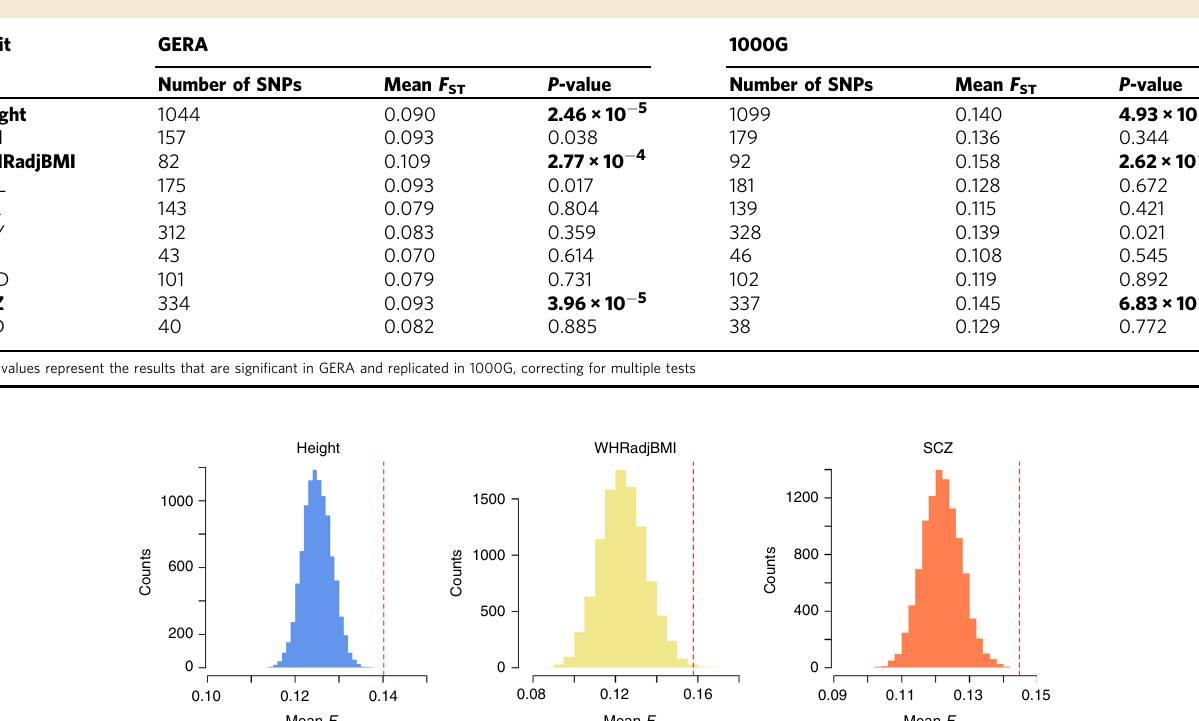
Table 1 Enrichment test of the differentiation of trait-associated SNPs (clumped at P < 5 × 10 − 6 ) in allele frequency against the control SNPs among the three populations in GERA and 1000G